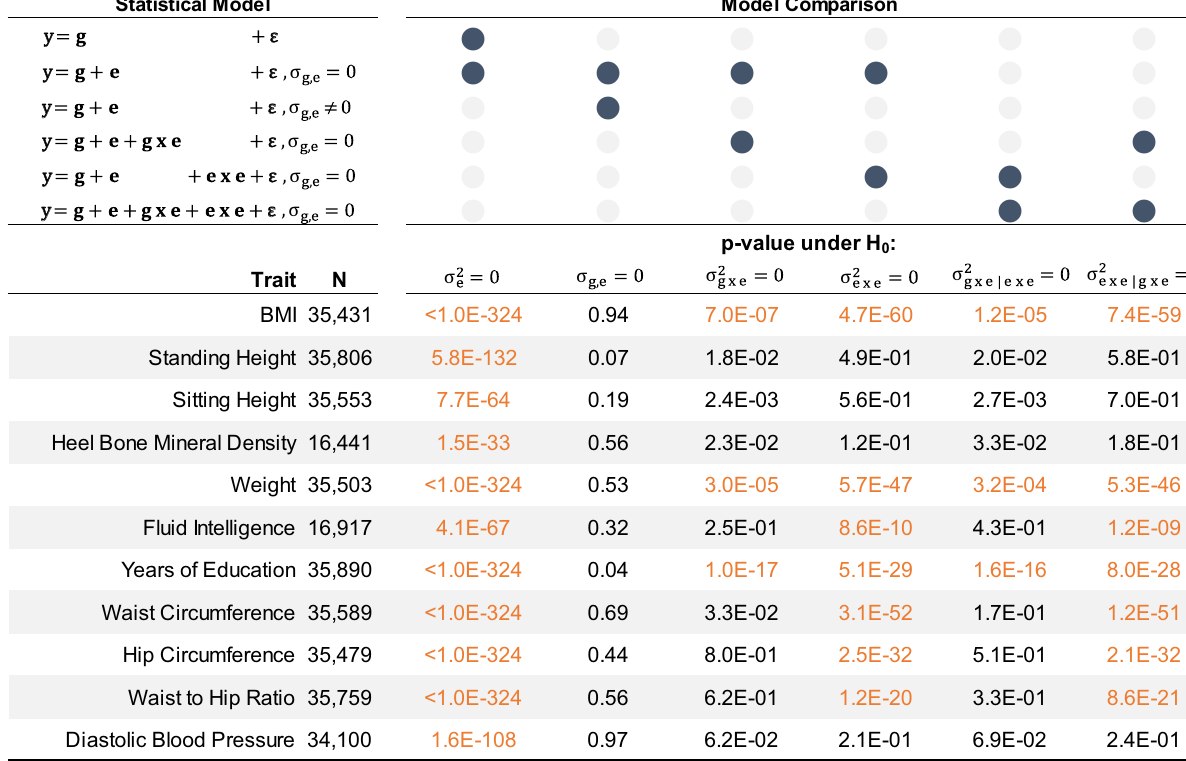
Table 1. P-values for estimated variance components of selected traits. Significant estimates are orange- coloured after applying Bonferroni corrected alpha level for each model comparison = 0.05/66 = 7.6E−04. See Table 2 for details of statistical